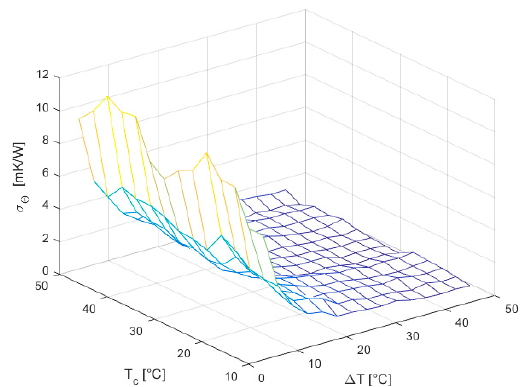
Figure 13. Standard deviation of thermal resistance Θ IN